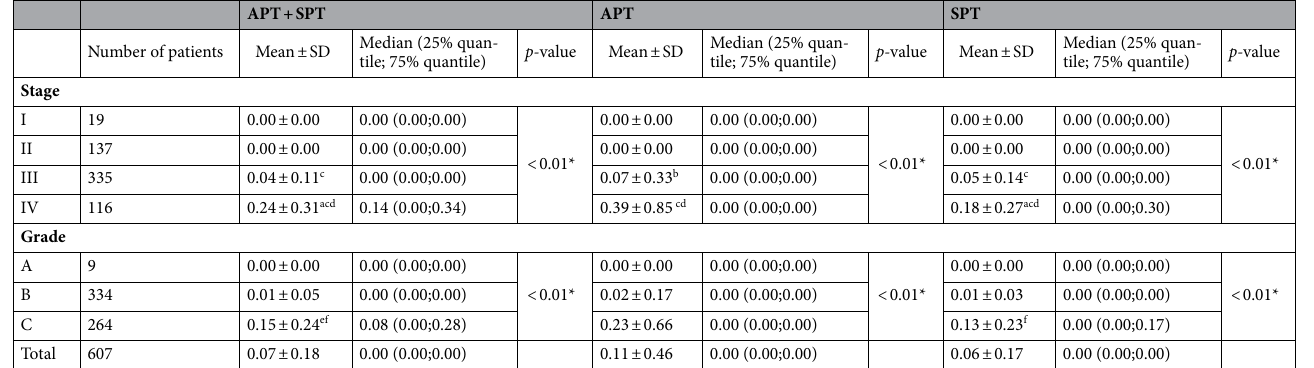
Table 3. Annual tooth loss per patient for each stage and grade during APT + SPT, APT, and SPT. Statistical analysis between the three or four groups was performed with the Kruskal–Wallis test followed by the Steel– Dwass post hoc test. SD standard deviation, APT active periodontal therapy, SPT supportive periodontal therapy. * p- value from the Kruskal–Wallis test. Significant difference by the Steel–Dwass post hoc test compared with Stage I ( p < 0.01:a), compared with Stage II ( p < 0.05:b, p < 0.01:c), compared with Stage III ( p < 0.01:d), compared with Grade A ( p < 0.05: e), compared with Grade B ( p < 0.01: f). 0.00 in the table shows that the number of extracted tooth was